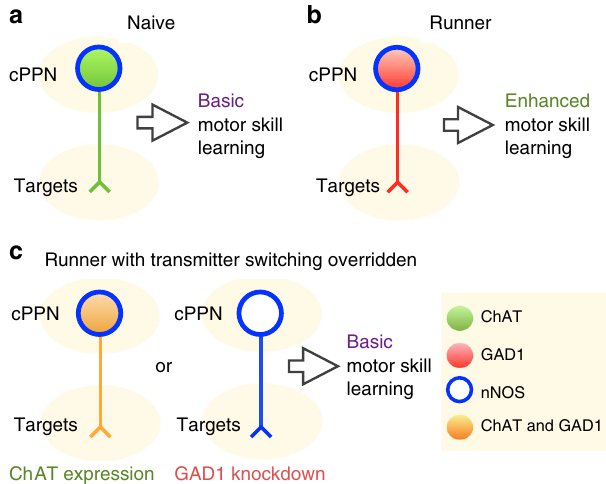
Fig. 8 Transmitter switching in the cPPN regulates motor skill learning. a , b Chronic running induces neurotransmitter switching from ACh to GABA in the cPPN and enhances motor skill learning. c Both ChAT loss and GAD1 gain are necessary for running-enhanced motor skill